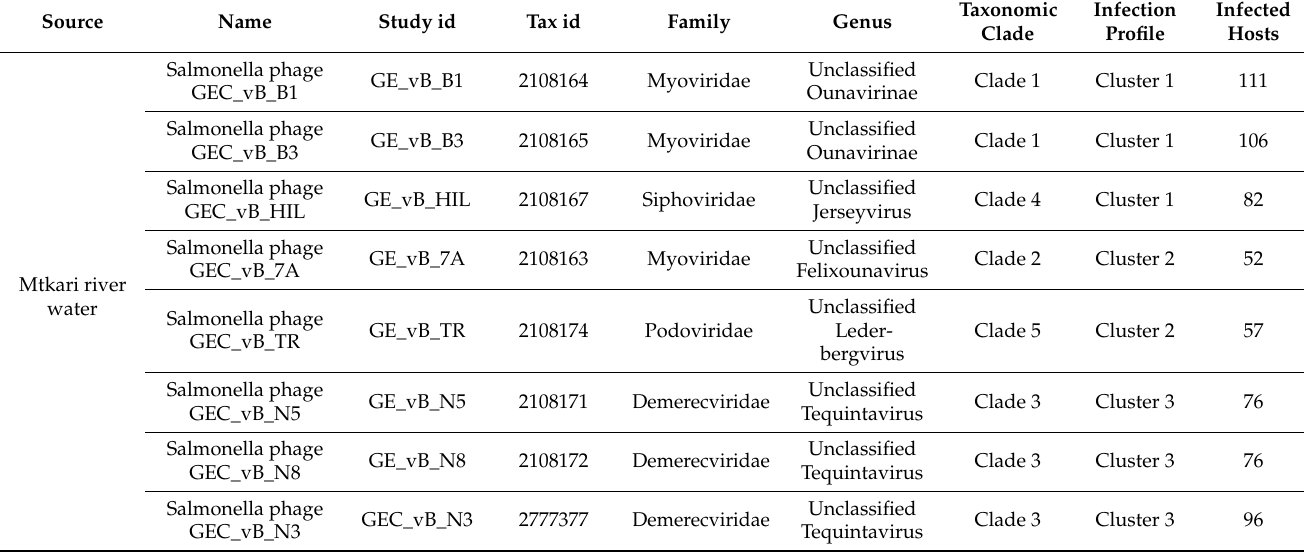
Figure 2. Salmonella phage–bacteria infection profiles and clustering. ( a ) Binary heatmap of the Salmonella phage–bacteria infection matrix representing positive (yellow) and negative (blue) in vitro infections. The matrix is organized according to the unsupervised hierarchical agglomerative clustering of the Jaccard similarity amongst the viral species (horizontal) ( b ) and the bacterial strains (vertical) ( c ). Strains and species with similar infection preferences (profiles) are positioned closer together in the cladograms in a bottom-up organization. Table 1. Characteristics of the Salmonella phage species. The table includes metadata on the characteristics of the 13 Salmonella phage species investigated in this study. These include the environmental source, the taxonomic clustering at the family and genus level and the phylogenetic clade, the infection profile cluster, and the target